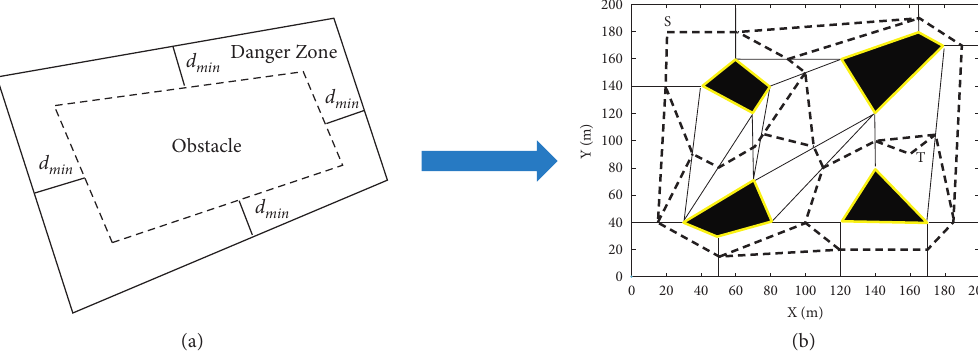
Figure 2: Modeling of underwater environment. (a) Modeling of obstacle. (b) Modeling of 2D map.